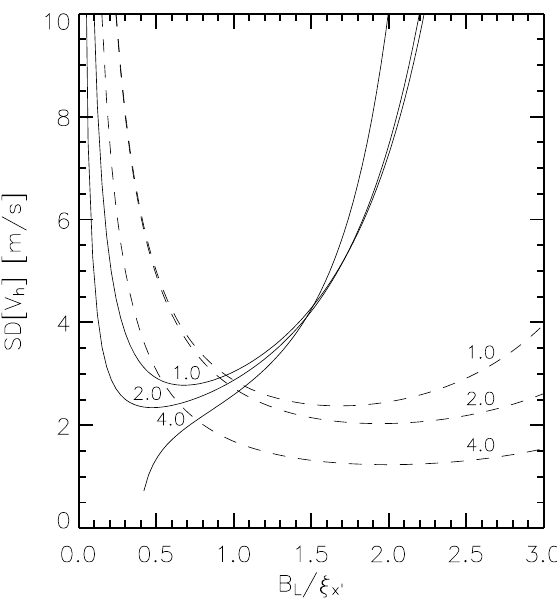
Fig. 3. Variance of wind (30m/s) as a function of isotropic diffrac- tion pattern scale ξ x 0 to baseline lengths B ij fixed at B L =52m. Cor- relation time T 0 . 5 varies from 1.0, 2.0, 4.0s. Results for baseline pair ( B 13 ,B 12 ) is shown in sold lines while results for baseline pairs ( B 12 ,B 23 ) and ( B 13 ,B 23 ) are shown in dashed lines. Observation time T d